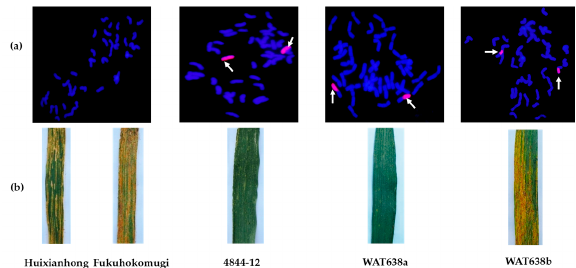
Figure 1. ( a ) GISH detection for the control Fukuhokomugi and the lines 4844-12, WAT638a and WAT638b containing intact 6P, 6PS and 6PL, respectively. A . cristatum chromosomal segments were in red, while wheat chromosomes were in blue strained by DAPI. ( b ) Evaluation of stripe rust of Huixianhong, Fukuhokomugi, 4844-12, WAT638a and WAT638b. Int. J. Mol. Sci. 2017 , 18 , 2403